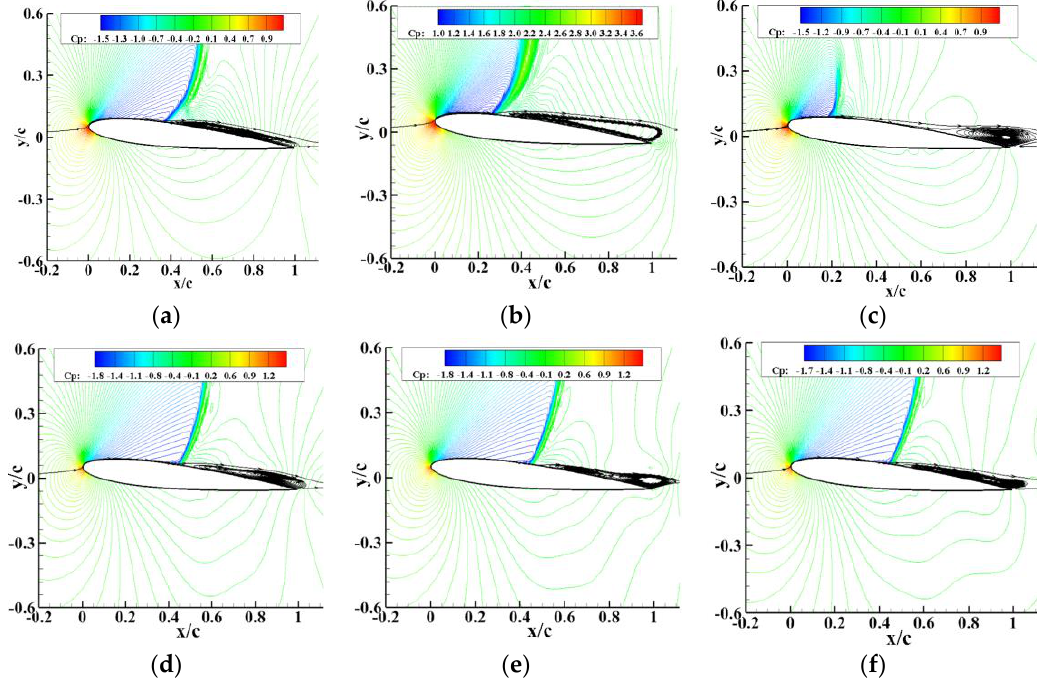
Figure 16. Streamlines corresponding to maximum/median/minimum lifts with and without tangential blowing. ( a ) Maximum lift without blowing; ( b ) median lift without blowing; ( c ) minimum lift without blowing; ( d ) maximum lift with blowing; ( e ) median lift with blowing; and ( f ) minimum lift with blowing.